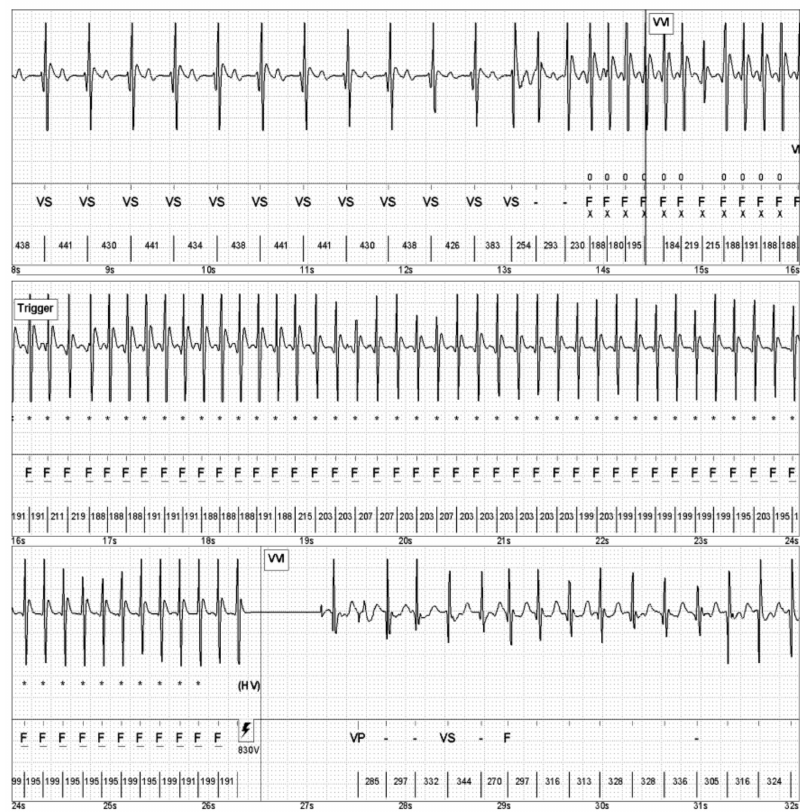
Figure 3. IEGM of a fast VT, appropriately terminated by shock